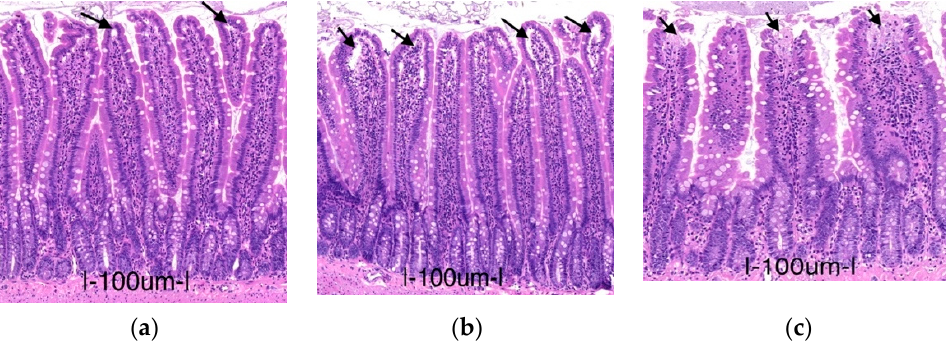
Figure 6. Representative pictures for mucosa changes after 6 h of preservation. Panel ( a ) represents the Rapa group. The arrows here point to subepithelial bleb at the tip of the villus, which corresponds to a Park/Chiu score of 1. Panel ( b ) represents the PC group. The arrows here point to more extended subepithelial spaces in the upper half of the villus (Park/Chiu score = 2). Panel ( c ) represents the 3-MA group. The arrows here show regions of epithelial breakdown and the denudation of villi (Park/Chiu score = 3).